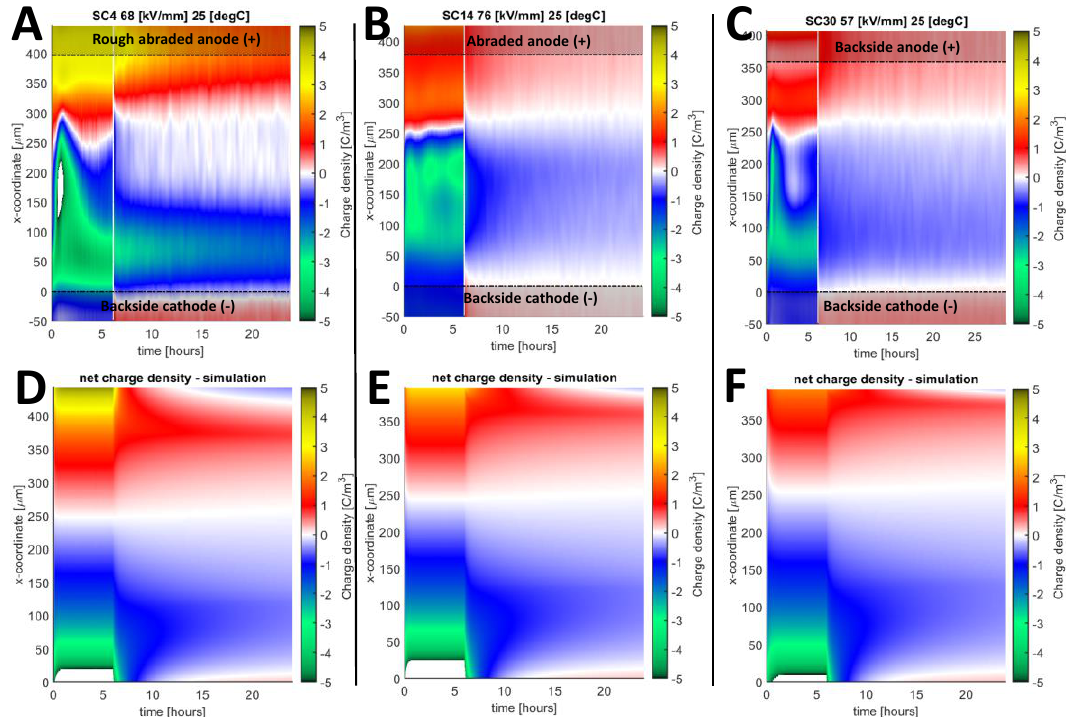
Figure 12. Colormap of net charge density in simulations ( D , E , F , bottom) and measurements ( A , B , C , top) for samples SC-4 ( A , D ), SC14 ( B , E ) and SC-30 ( C , F ). All samples were subjected to + 30 kV biasing at 25 °C. Negative charge packets are observed in measurements, represented with the green peaks during the first hours of polarization.